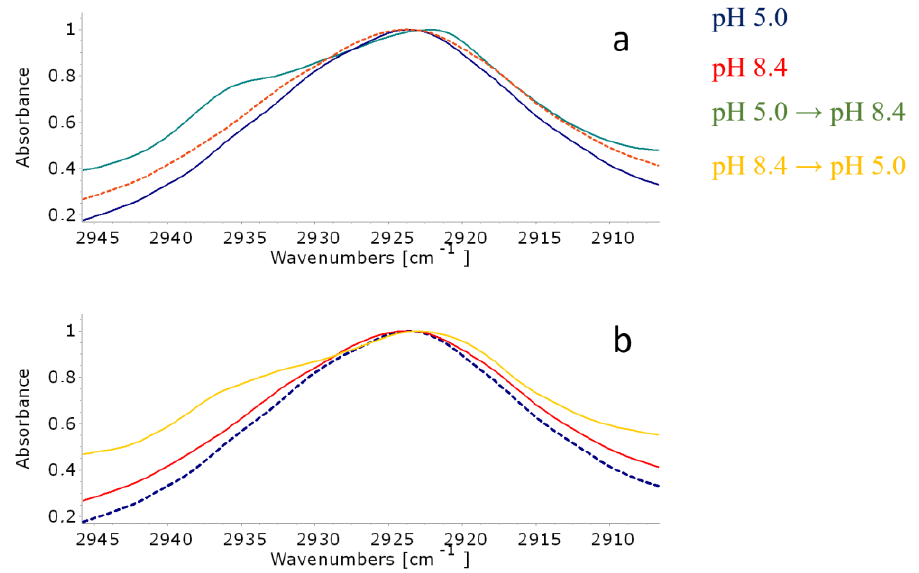
Figure 7. Normalized ATR-FTIR spectra of POPC/AMS liposomes (absorption region of asymmetric stretching vibrations of methylene groups) under various conditions: ( a ) liposomes at pH 5.0 (blue), at pH 8.4 (red dashed line), and converted from pH 5.0 to 8.4 (green); ( b ) liposomes at pH 5.0 (blue dashed line), at pH 8.4 (red line), and converted from pH 8.4 to pH 5.0 (yellow). Total lipid concentration 5 mg/mL, α AMS = 0.1, 22 ◦